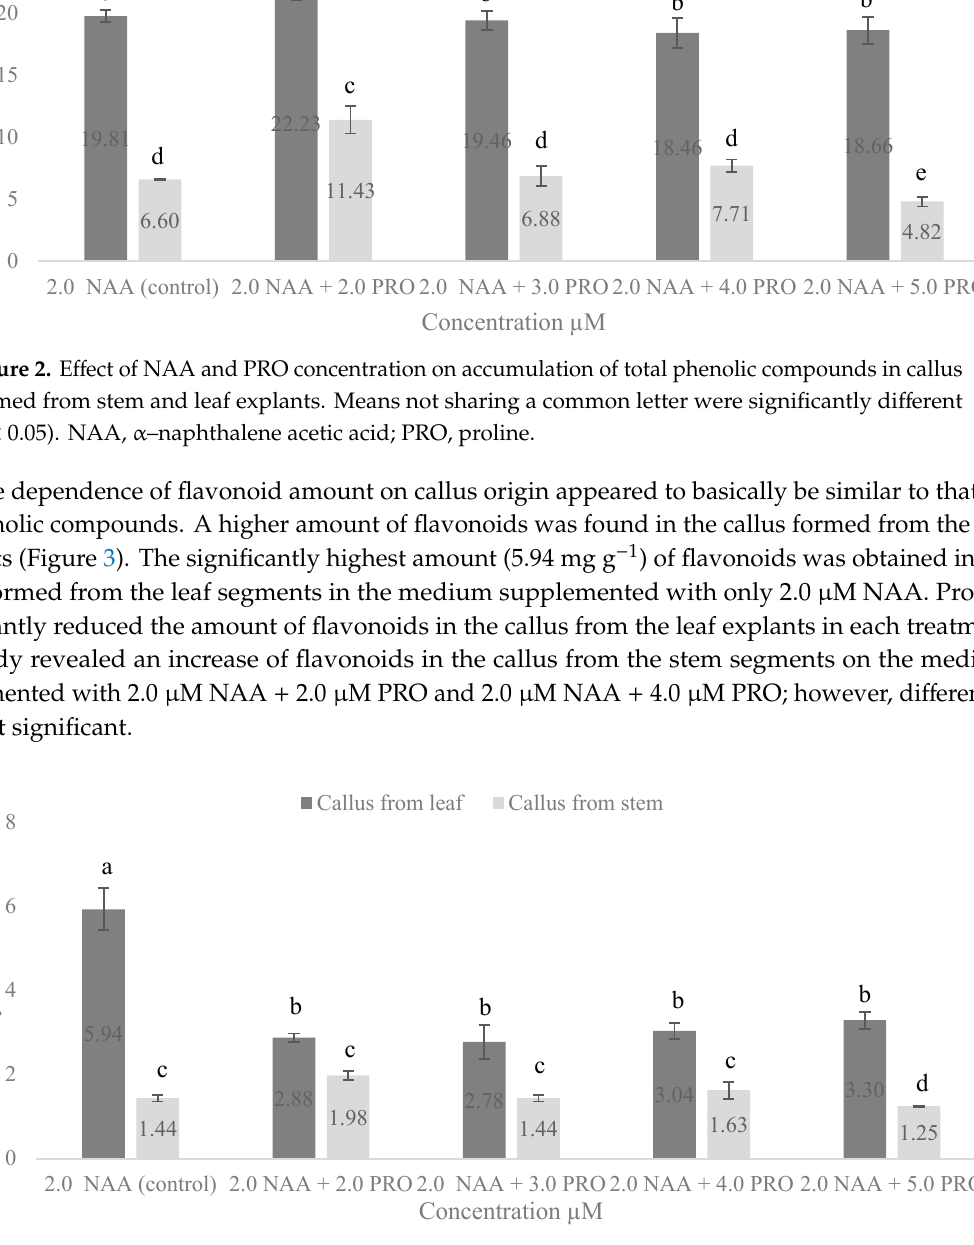
Figure 3. Effect of NAA and PRO concentration on accumulation of total flavonoids in callus culture from stem and leaf explants. Means not sharing a common letter were significantly different ( p < 0.05). NAA, α –naphthalene acetic acid; PRO, proline.